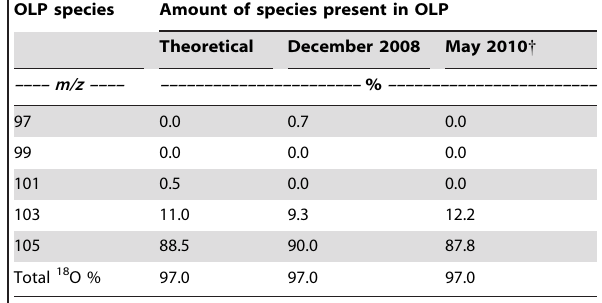
Table 2. Amount of each oxygen labeled phosphate (OLP) species present in OLP synthesized with pure POCl 3 during two separate synthesis events with either fresh POCl 3 or with POCl 3 previously opened and stored containers as compared to the theoretical